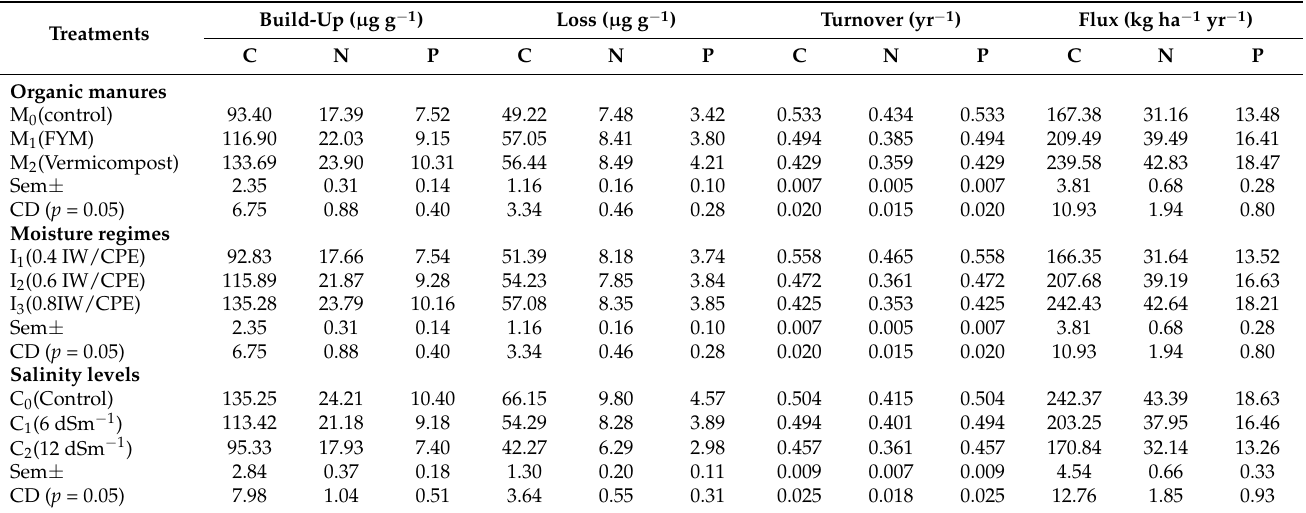
Table 2. Effect of organic manures, moisture regimes, and salinity levels on build-up, loss, turnover and annual flux rate of soil microbial biomass C, N, and